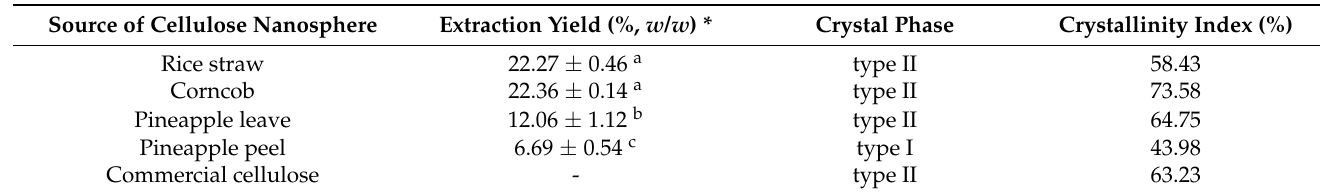
Table 1. Extraction yield, crystal phase and crystallinity index (CI) of cellulose nanosphere extracted from different sources compared with commercial cellulose.